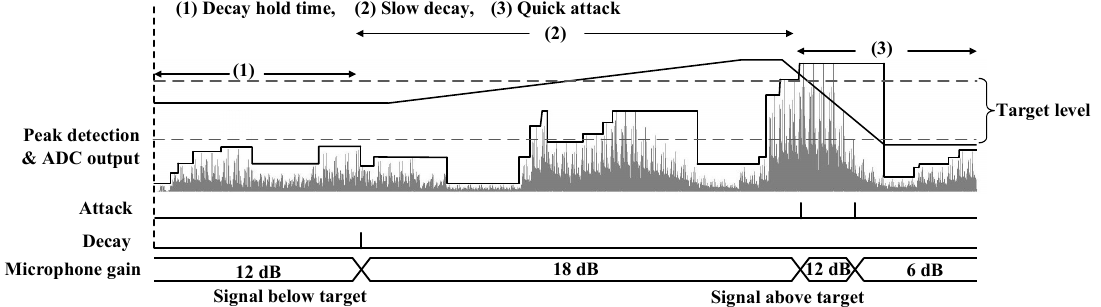
Figure 4. Principle of microphone automatic gain control (AGC) loop.